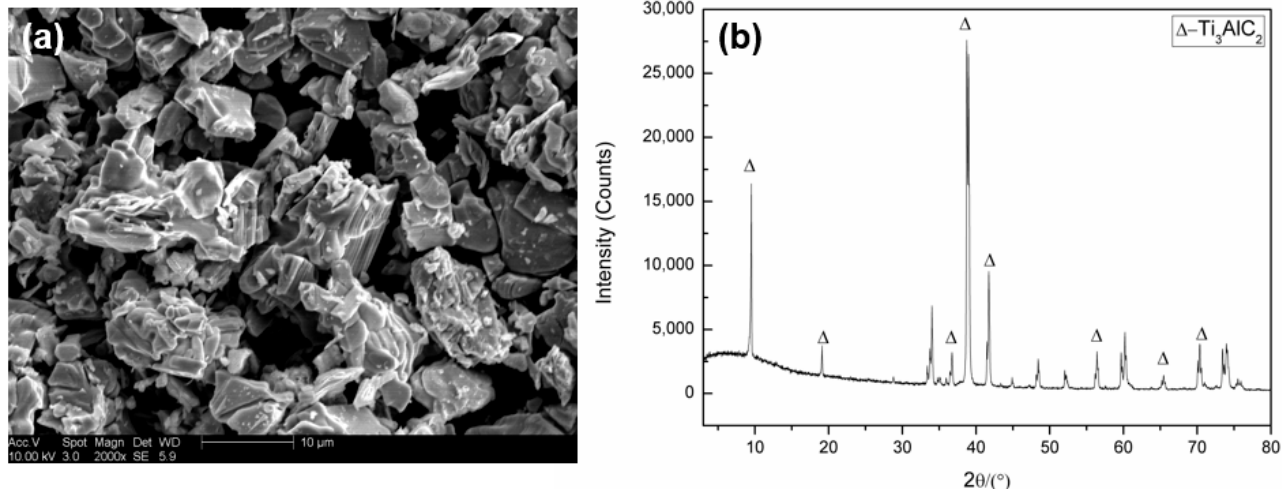
Figure 1. ( a ) Micromorphology and ( b ) composition of Ti3AlC2